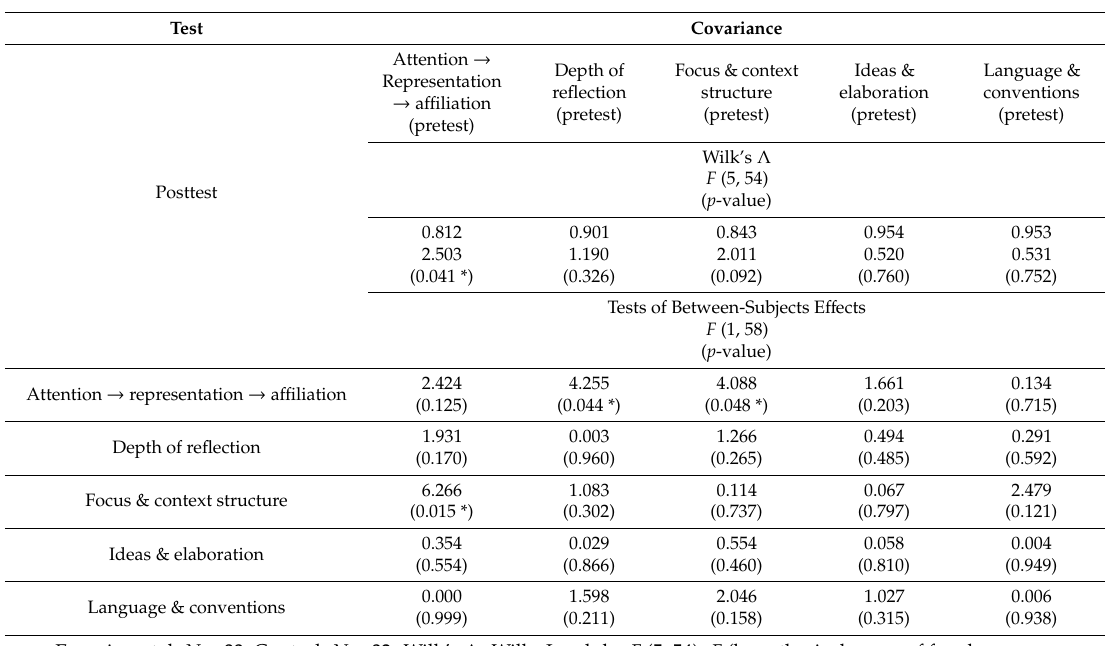
MANCOVA results for the Analytic Narrative Medicine Writing Scoring Rubric (ANMWSR) posttest.